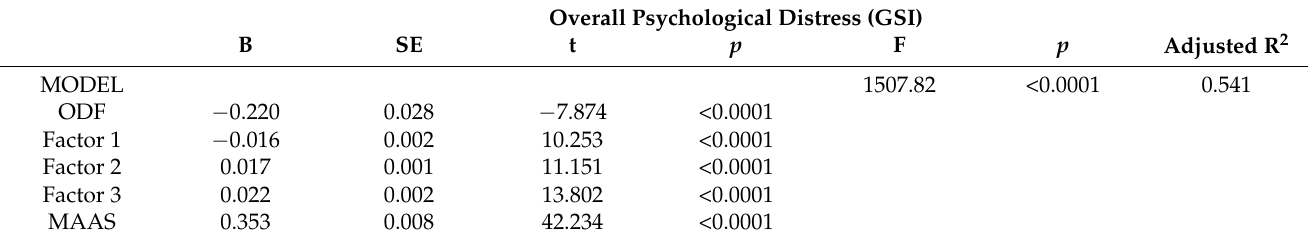
Table 3. Multivariate linear regressions for mindfulness and defense mechanisms predicting psycho- logical distress (N = 6385).